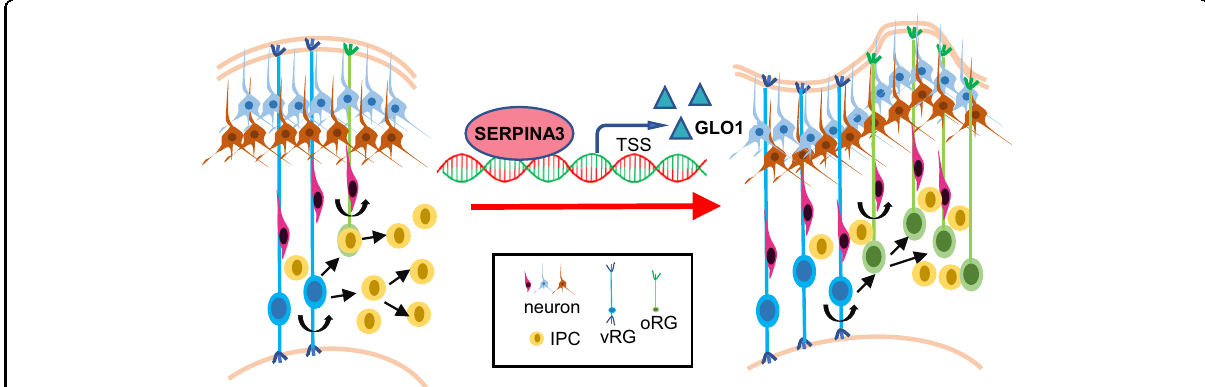
Fig. 8 Proposed model for the role of SERPINA3 in cortical expansion and folding. SERPINA3 targets Glo1 to increase the expansion of NPCs, especially BPs, giving rise to an increased number of neurons and leading to cortical